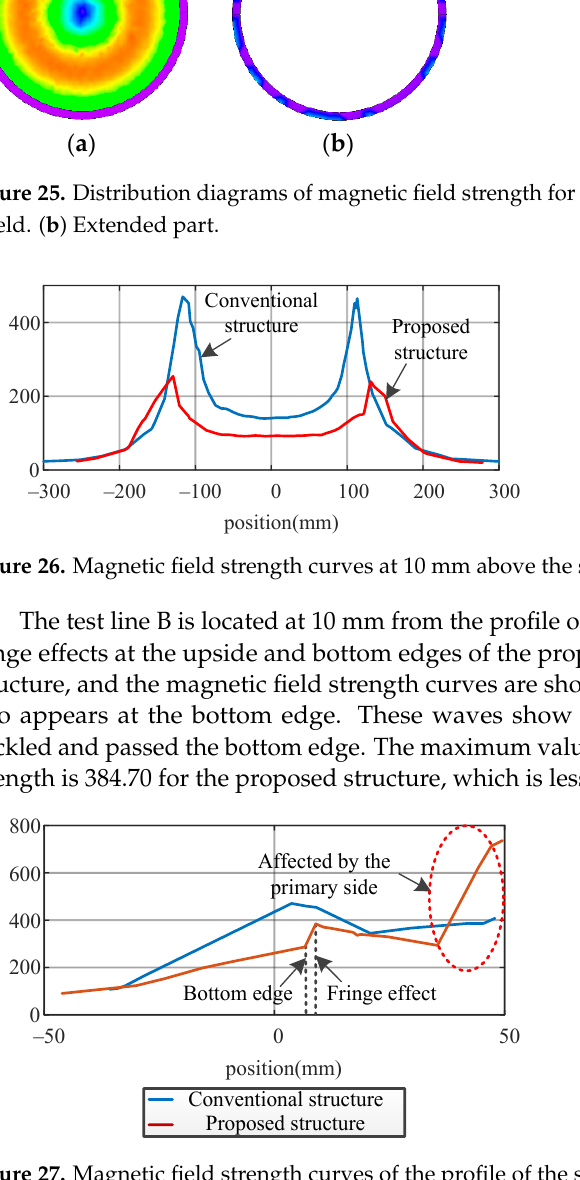
Figure 27. Magnetic field strength curves of the profile of the shields.